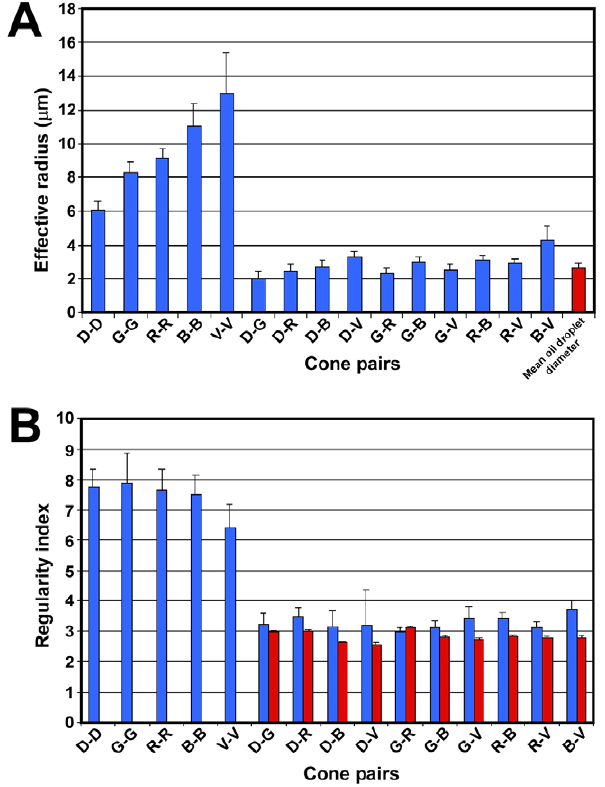
Figure 5. Cone mosaics are spatially independent. (A) Graph of the effective radius between cones of the same type (homotypic pairs) and different types (heterotypic pairs). Also shown for comparison is the average oil droplet diameter for all cone types. ‘D-D’, ‘Double cone- Double cone’; ‘G-G’, ‘Green cone-Green cone’ etc. Error bars are SD. (B) Graph of the nearest neighbor regularity indices for cones of the same type (homotypic pairs) and different types (heterotypic pairs) (blue bars). Also shown are regularity indices for simulated mosaics as described in the main text (red bars). Abbreviations are as in (A). Error bars are SD.